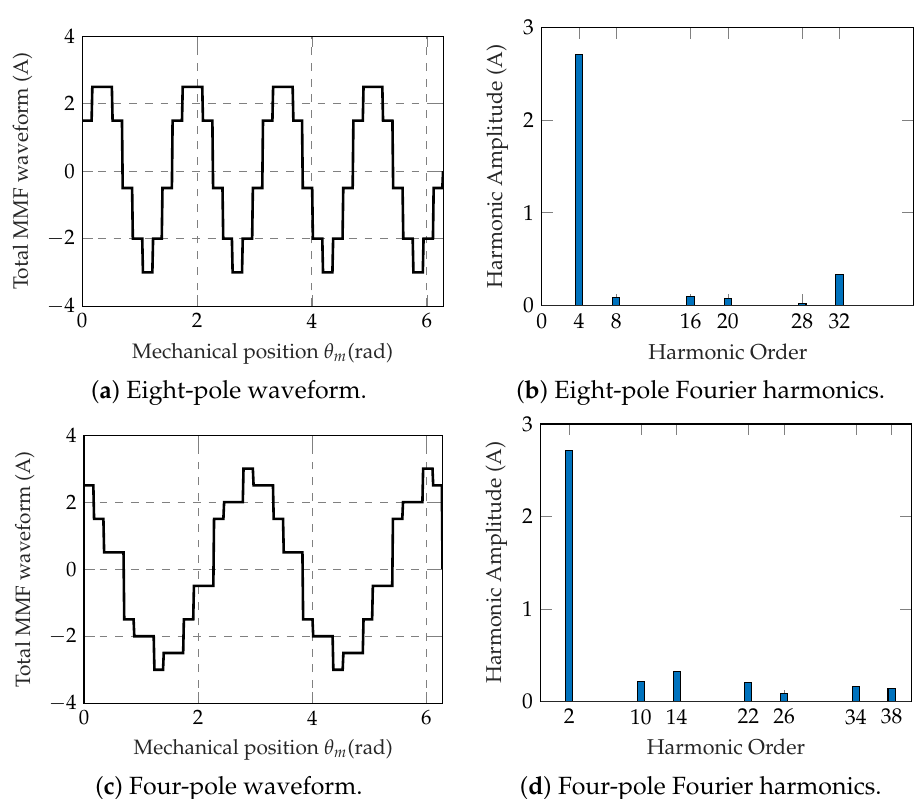
(d) 4-pole Fourier harmonics. Figure 7. MMF waveform due to stator currents and harmonic content of both configurations. Table 1 summarizes stator geometric data and stator winding data. Table 1. Stator